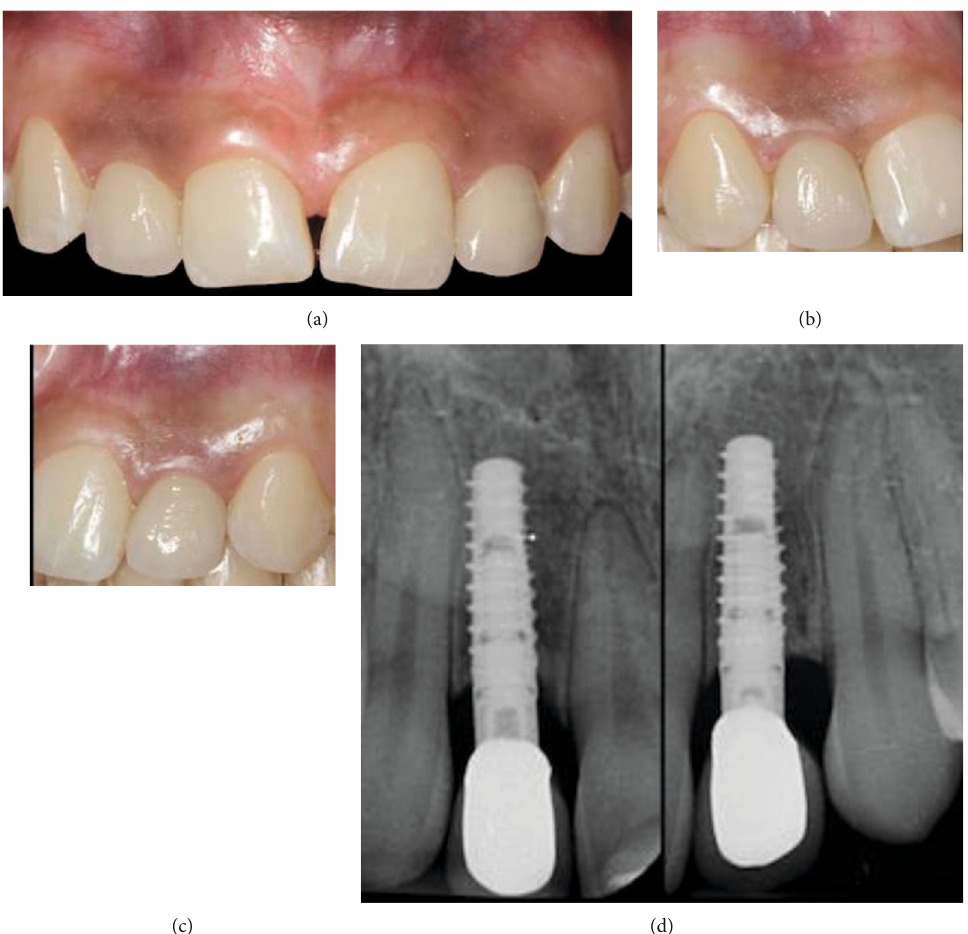
Figure 6: (a) Facial view of the de fi nitive restorations at the 24-month follow-up. (b) Right lateral view of the de fi nitive restorations at the 24- month follow-up. (c) Left lateral view of the de fi nitive restorations at the 24-month follow-up. (d) Periapical radiographs at the 24-month